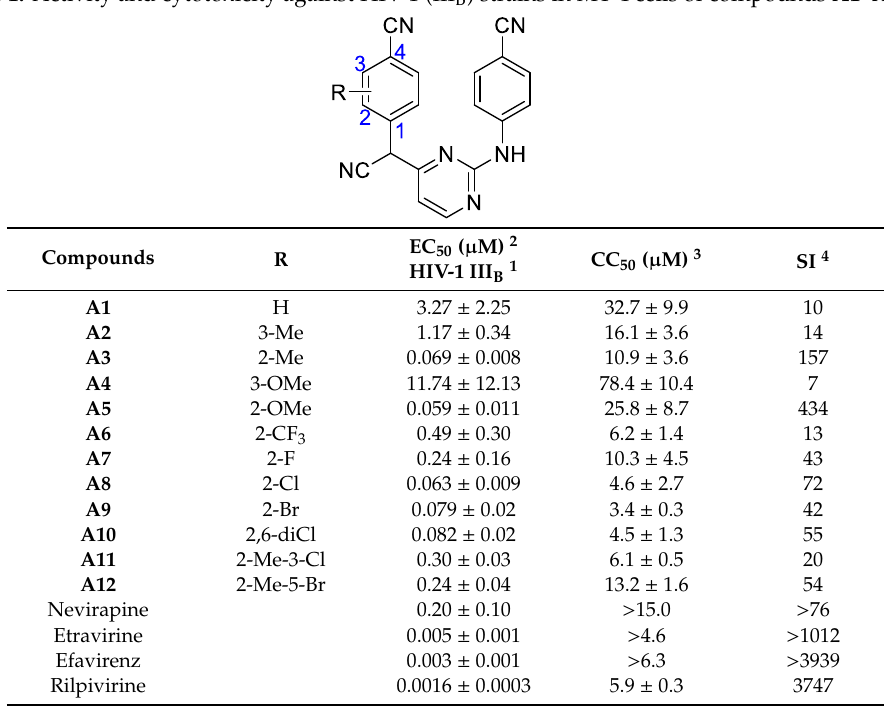
Table 1. Activity and cytotoxicity against HIV-1 (III B ) strains in MT-4 cells of compounds A1 – A12 .